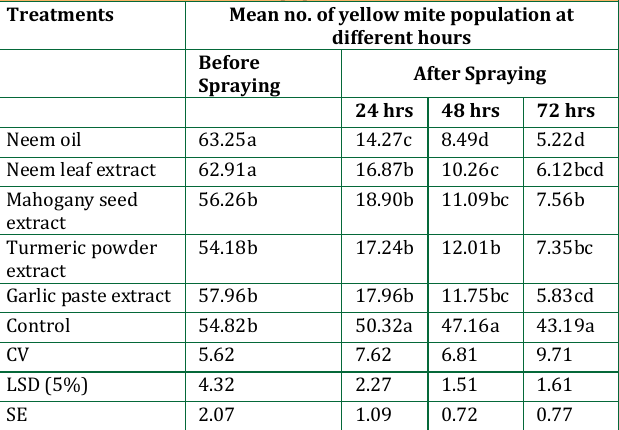
Table 1: Effect of different plant extracts on the survival of yellow mite population